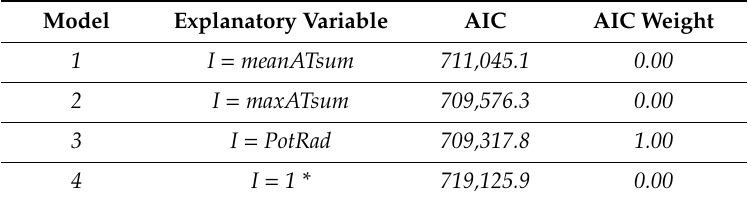
Table 2. Model formula and Akaike information criterion (AIC) for the four fitted logistic regression models selected for 2005 to 2014 in the High Tatra Mountains. I signifies infestation by bark beetles; * intercept-only model.